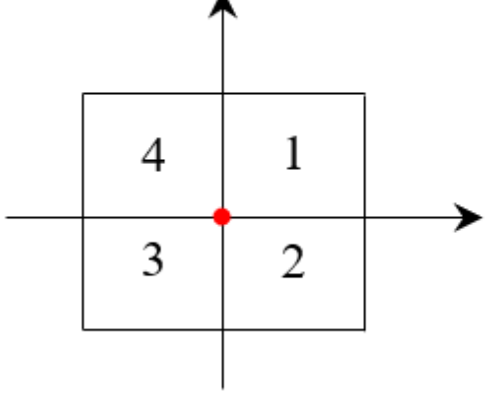
Figure 1. Example of the